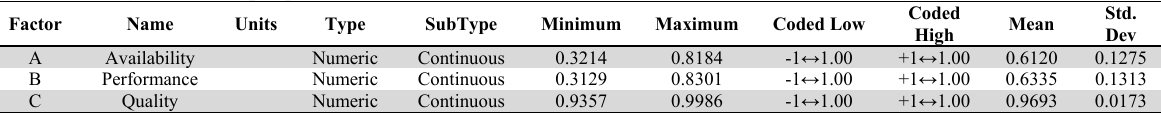
Statistical analysis of the input parameters